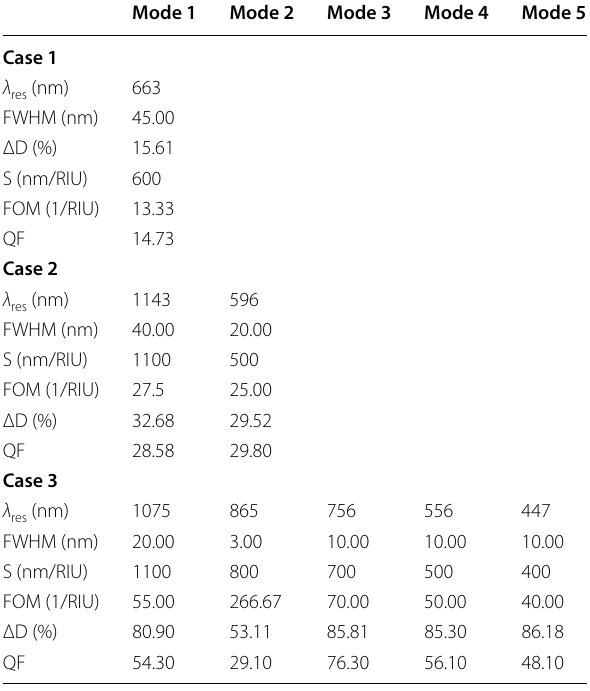
Fig. 2 Comparison of the transmittance spectrum of the SPPs mode for cases 1–3 structures